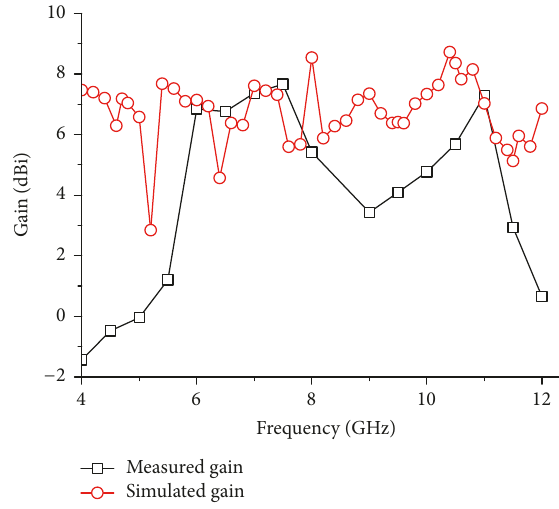
Figure 15: Simulated and measured gain of